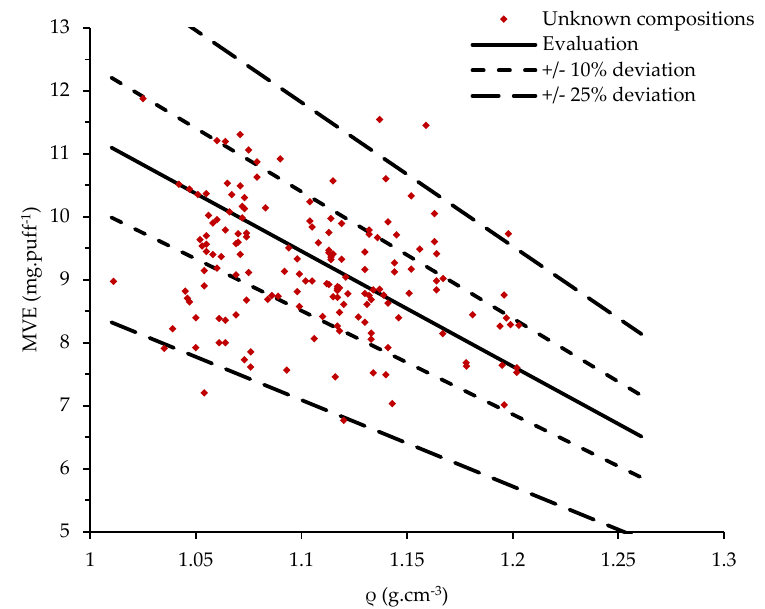
Figure 9. MVE—Distribution of the measured values for the liquids with unknown compositions.